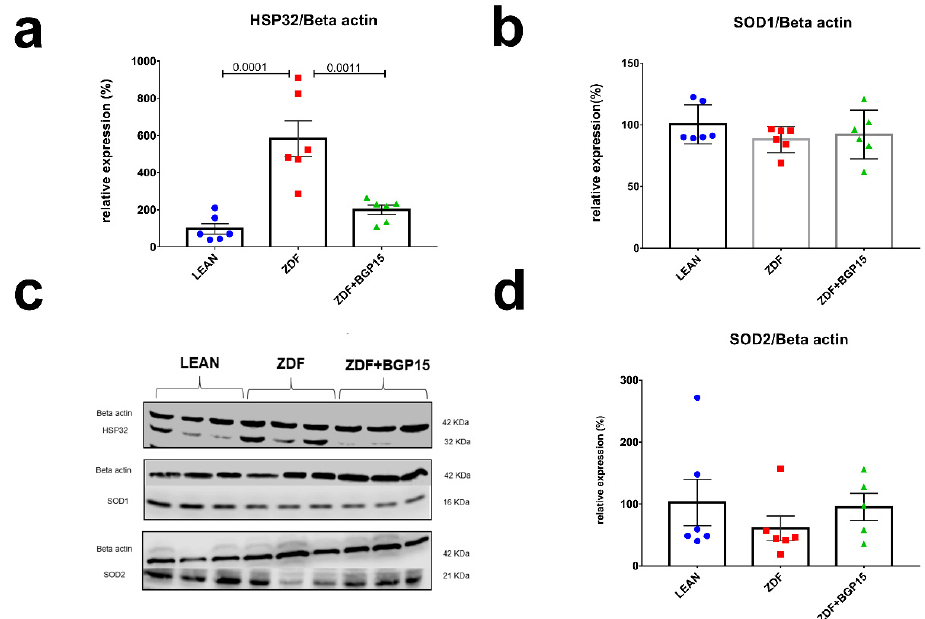
Figure 4. Expressions of antioxidant proteins from rat myocardium. HO-1 protein expression elevated significantly to diabetes induced oxidative stress in aged rats. ( a , b , d ) quantitative band density analyses of HO-1, SOD1, and SOD2 proteins normalized to Beta actin and expressed in the percentage of LEAN (that was considered 100%). ( c ) A representative Western blot for Beta actin, Hsp32, SOD1, and SOD2 in ZDF rat myocardium treated with BGP-15. All data are presented as the average outcome in a group (mean) ± standard deviation (SD). Statistical analysis was carried out by GraphPad Prism 7.00: D’Agostino and Pearson normality test was used to estimate Gaussian distribution than data were analysed with ordinary one-way ANOVA or Kruskal–Wallis test. The groups were matched by Tukey’s multiple comparisons test.